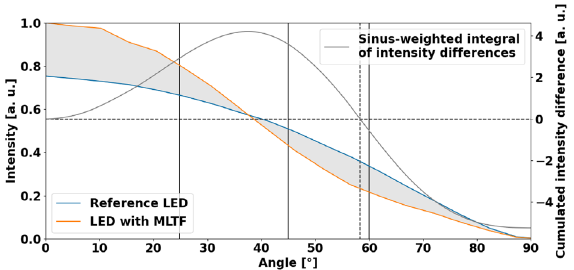
Figure 7. The normalized intensity of an LED with and without a multi-layer thin film (MLTF) is denoted on the left axis. The sinus-weighted integral over the intensity difference (grey area)—the so-called cumulated intensity difference —on the right axis indicates that a directionality increase can be achieved up to 58.4 ◦ . However, the peak of directionality increase is observed between 35 ◦ and 40 ◦